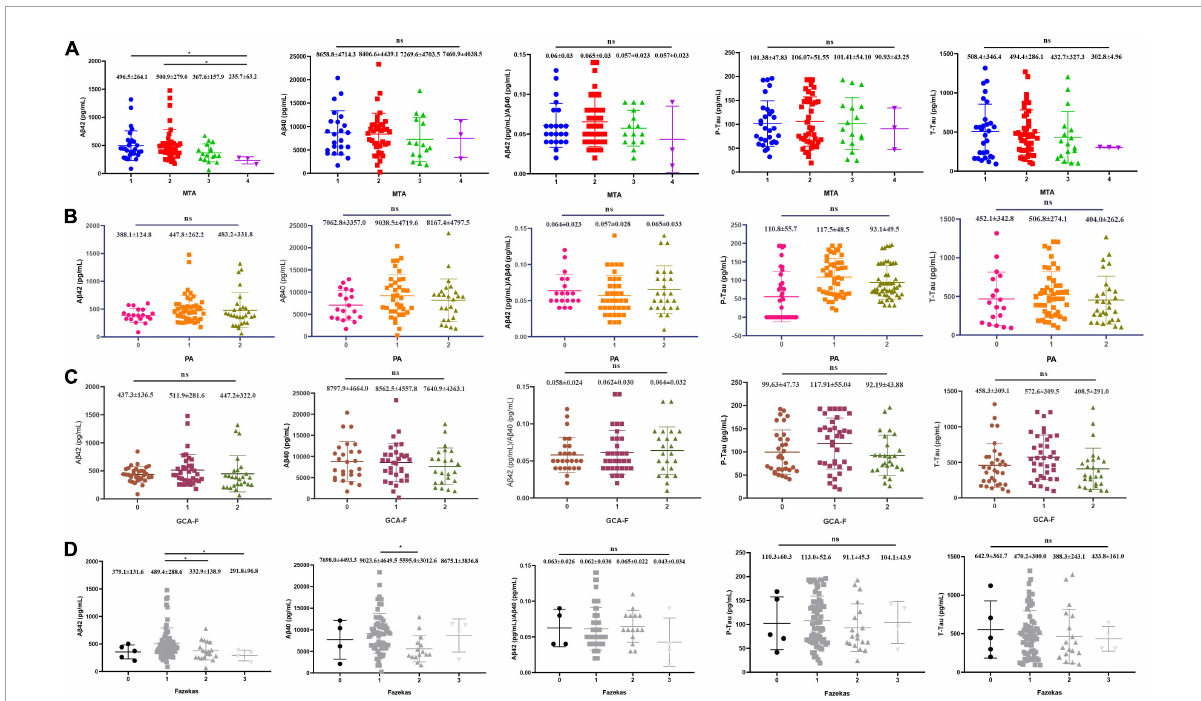
FIGURE3 Each visual rating scale and correlation of CSF core biomarkers. (A) MTA ( N = 92), (B) PA ( N = 95), (C) GCA-F ( N = 95), and (D) Fazekas ( N = 95). P -values from ANOVA (Kruskal–Wallis H -test for abnormal distribution), and Games–Howell test for post-hoc comparison. * P < 0.05 was statistically significant; ns: no statistical